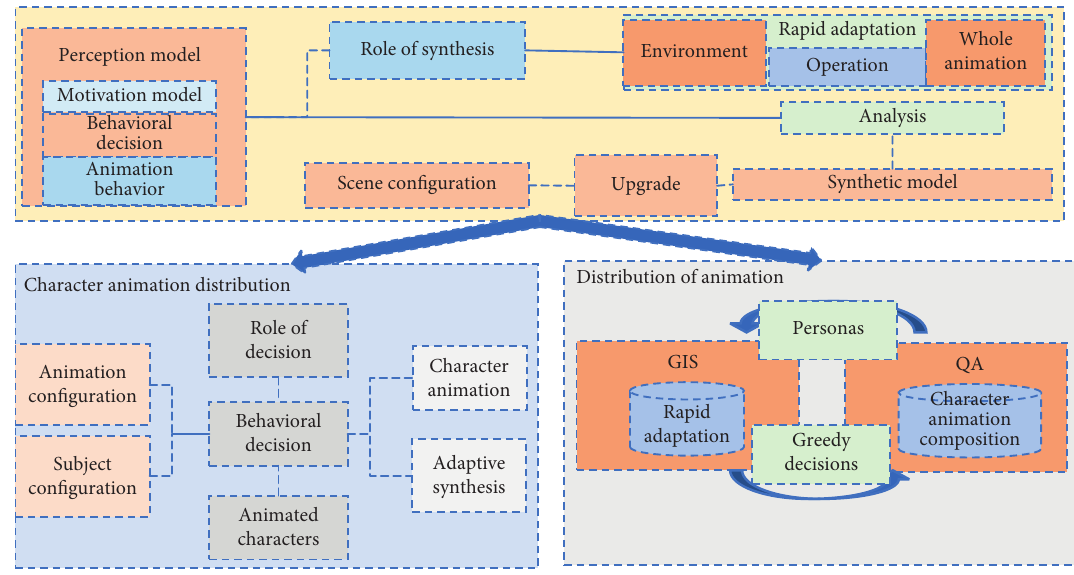
Figure 1: Flowchart of the autonomous character animation synthesis